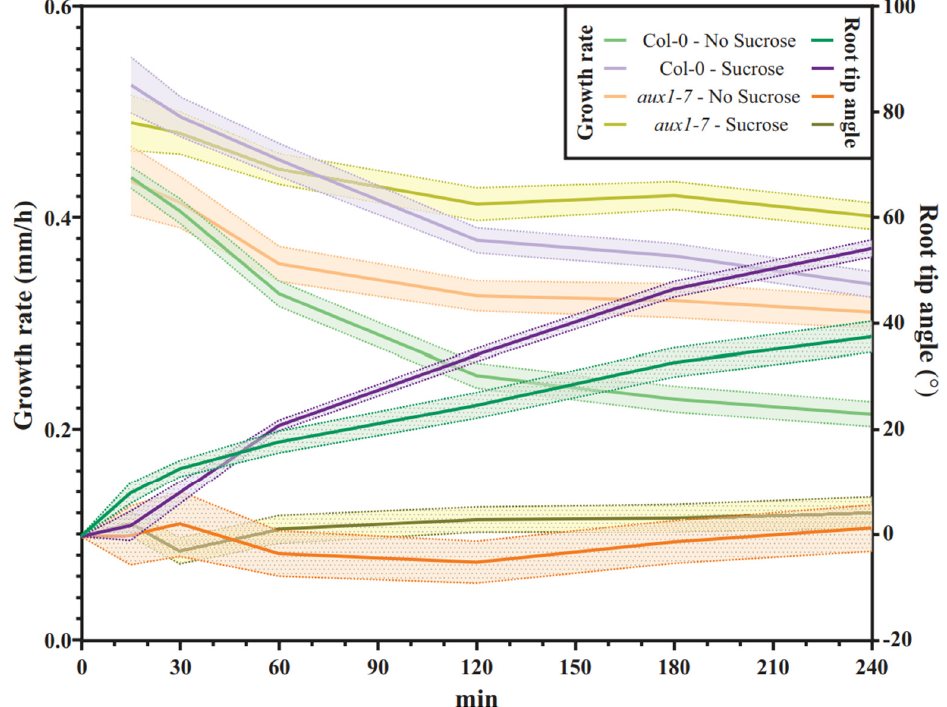
Figure 7. Time course of root bending upon gravistimulation of Col-0 and aux1-7 7DAG seedlings grown in agar with covered roots with or without sucrose supplementation. Root growth rates (left axis) versus root rip angles (right axis) are shown. (Col-0, n = 42–51 roots; aux1-7 , n = 13–20 roots).